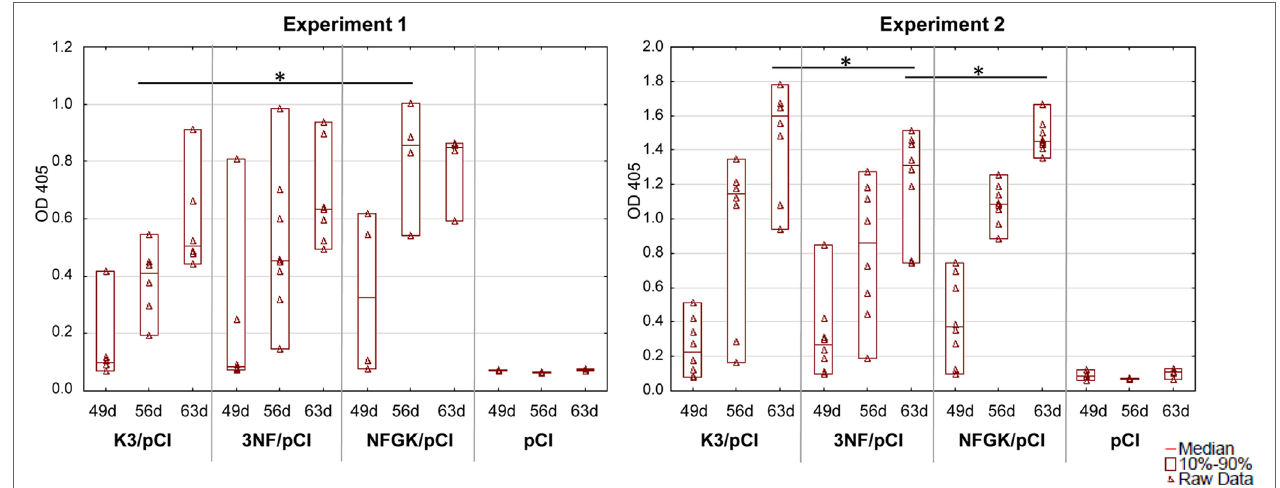
FigUre 2 | Immune response of mice to the tested variants of the DNA vaccine. The results of the one-dilution ELISA test shown for individuals with medians and the 10th and 90th percentiles indicated for each group, where applicable (Experiments 1 and 2). All sera were diluted 100-fold. Statistically significant differences ( p < 0.05) are marked by